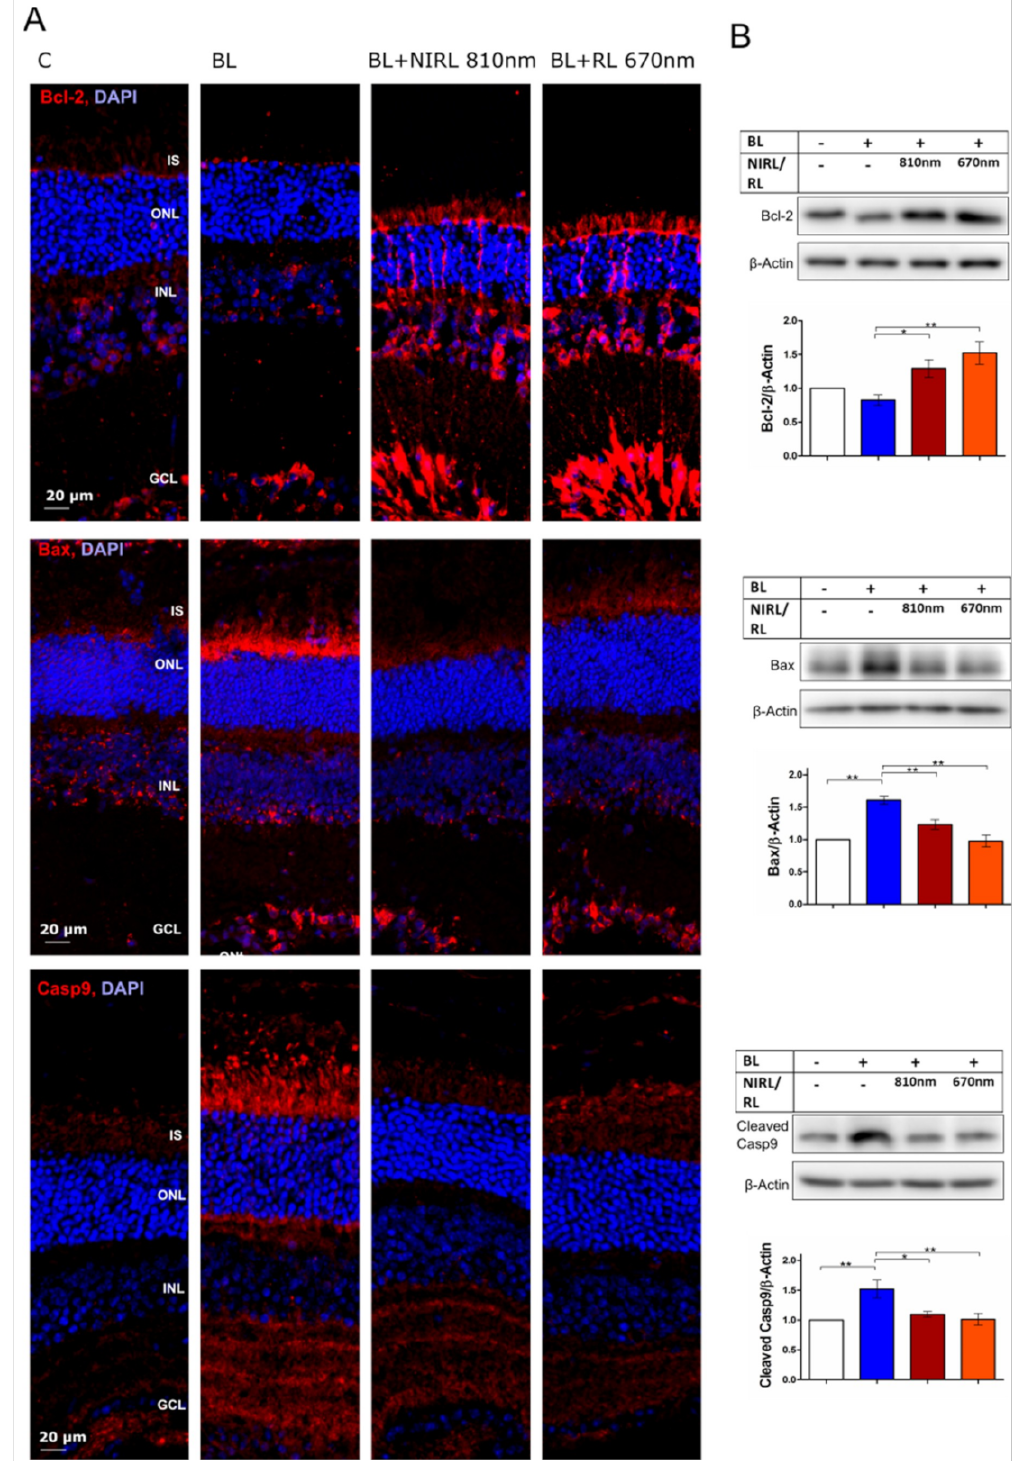
Figure 2. NIRL and RL inhibit mitochondria induced apoptosis pathway through Bcl-2, Bax and Caspase-9 regulation. ( A , B ) Late event analysis after 9 h of cultivation. Eyes were treated for 6 h with BL, following 10 min NIRL or RL and post-cultivated for another 3 h. ( A ) Representative images of Bcl-2, Bax and Caspase-9 (Casp9) immunohistochemical staining in retinal sections. Retinal layers: outer segments [OS], inner segments [IS], outer nuclear layer [ONL]. N = 3 experiments. ( B ) Western blot analysis of retinal lysates using antibodies against Bcl-2, Bax and Caspase-9 and β -Actin as loading control. Protein level was quantified using ImageJ. N = 6 experiments ± standard error of the mean (SEM). * p < 0.05, ** p < 0.01 compared with blue